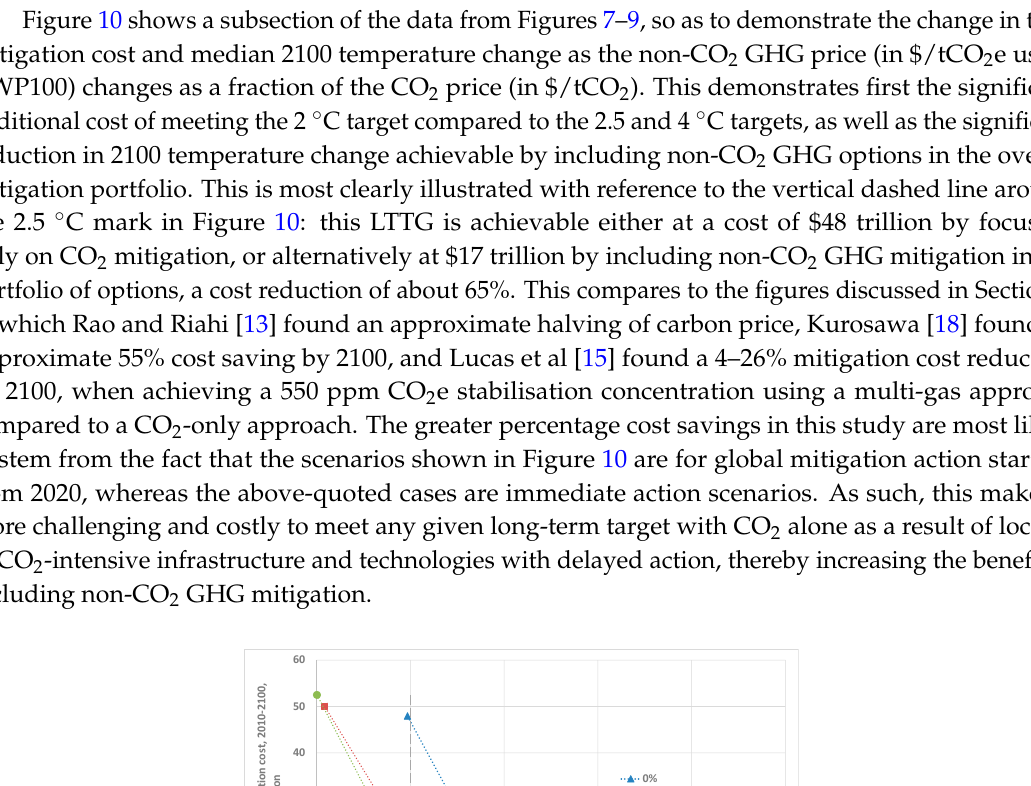
Figure 10. Costs of achieving different long-term temperature goals with varying degrees of non-CO 2 mitigation (in terms of CO 2 e prices as a fraction of CO 2 prices).